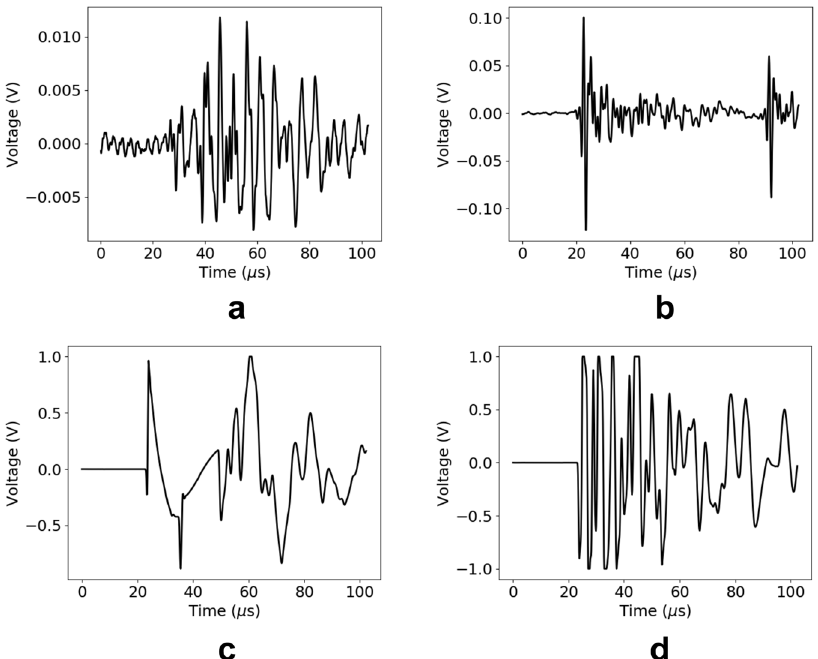
Fig. 6 Examples of removed waveforms. a Low signal-to-noise ratio, b two distinct damage events occurring in the same time window, and c , d events that saturated the AE sensor. The majority of removed waveforms were of types a , c , and d . Less than ten waveforms were of type b across the three